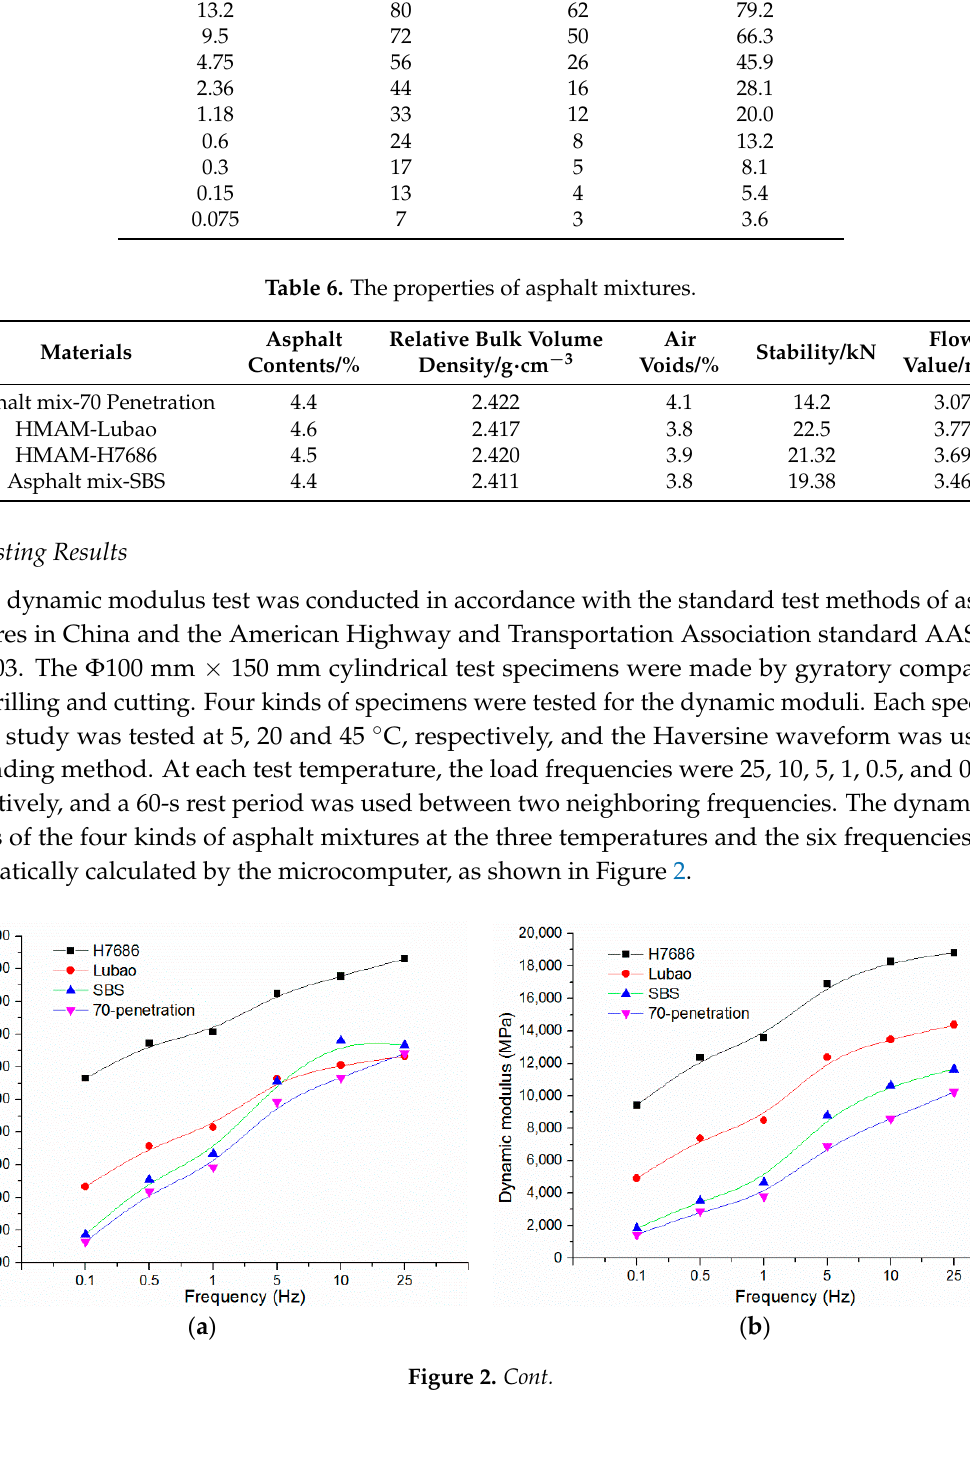
Table 5. Aggregate gradation.